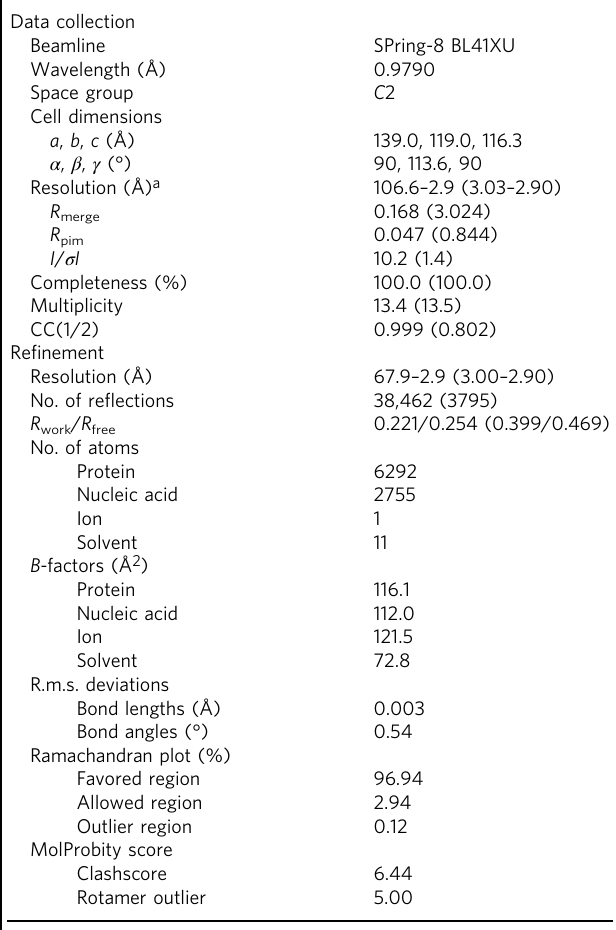
Table 1 Data collection and re fi nement statistics Data collection